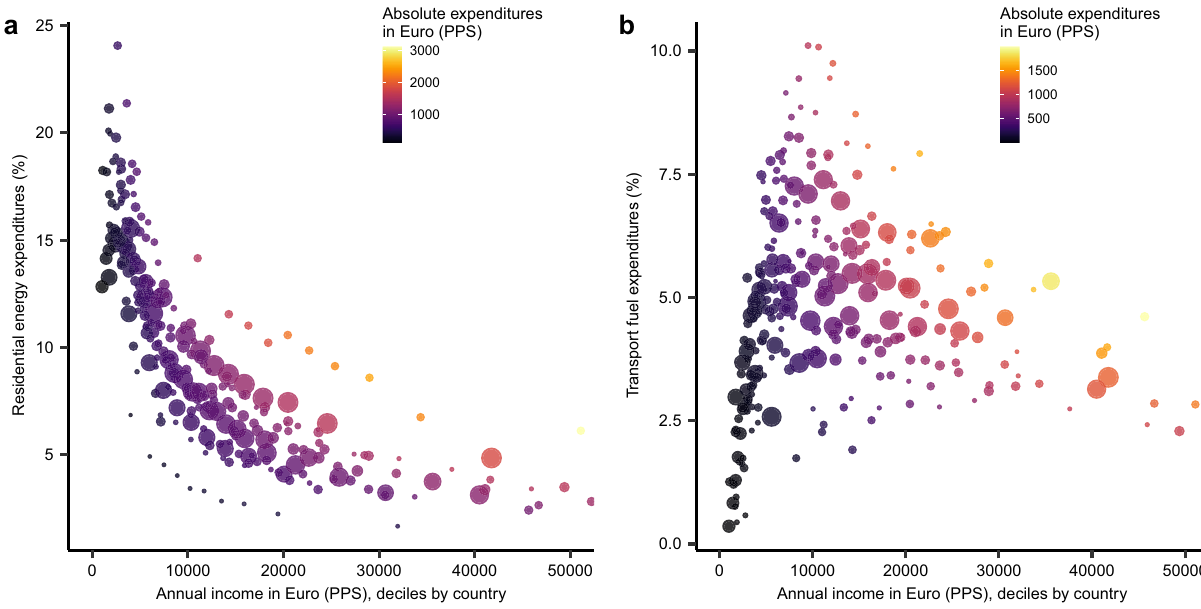
Figure 2. Expenditure shares of residential and transport energy by income group and country. Share in total expenditures of ( a ), residential energy (CP045), and ( b ) fuels and lubricants for personal transport equipment (CP0722). Lines connect the income deciles within a country. Incomes and absolute expenditures are annual and expressed in purchasing power standards. Truncated horizontal axis does not show the tenth decile for Luxembourg. PPS, Purchasing Power Standard. Source: Household Budget Survey 2015,